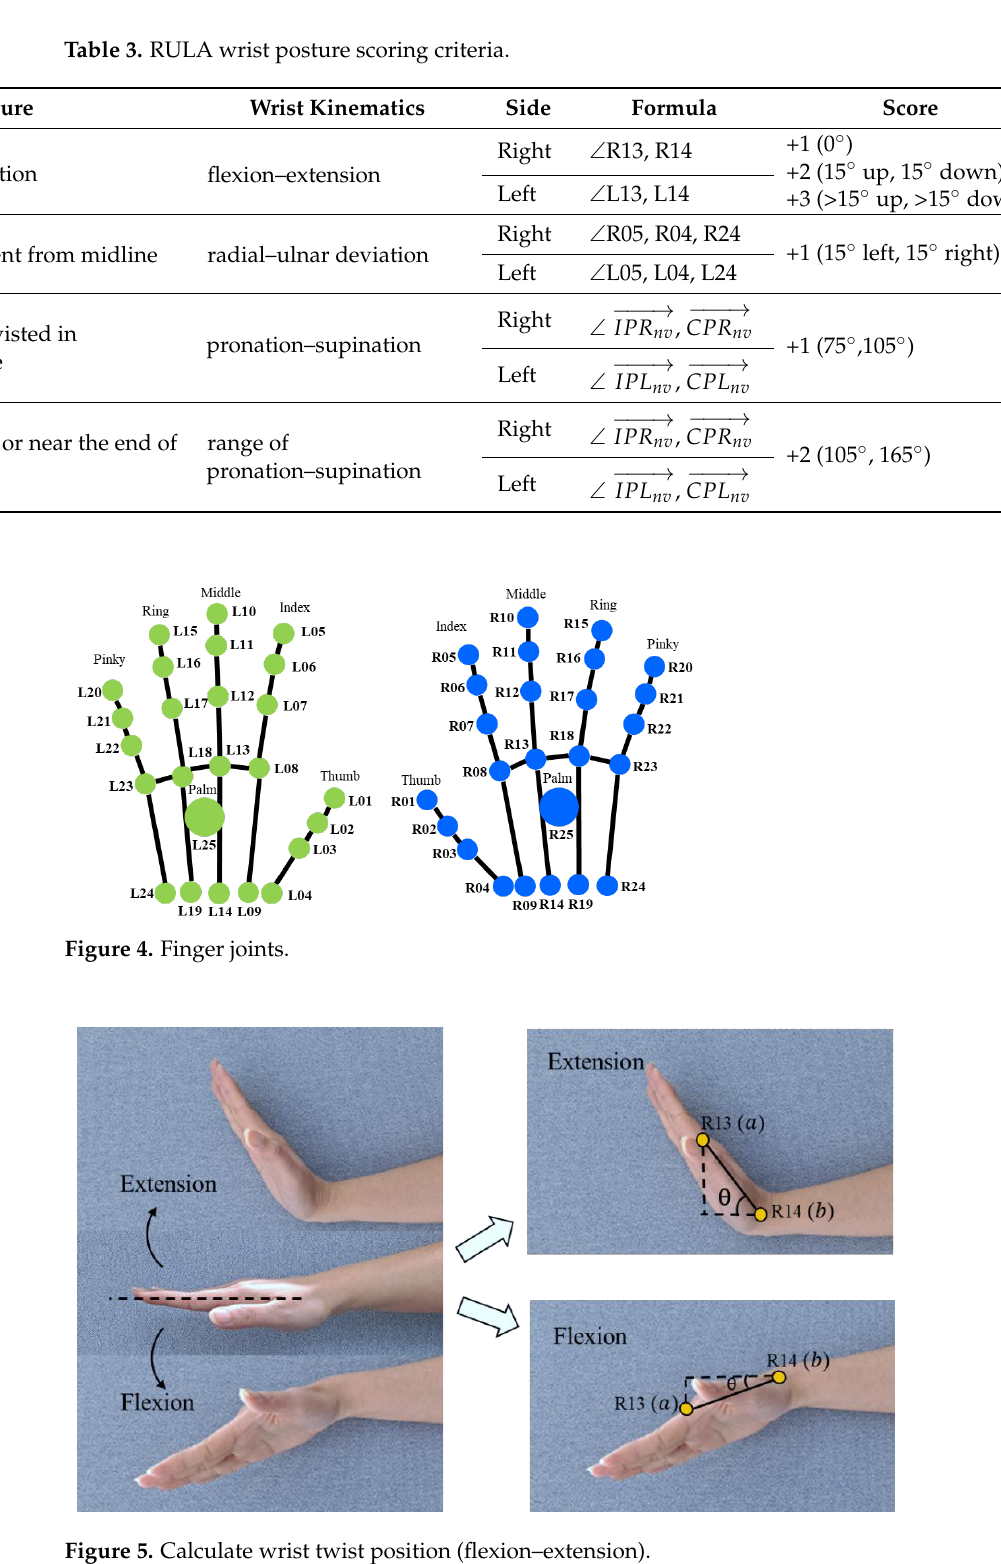
7 of 23 Figure 3. RULA Scoring Mechanism.